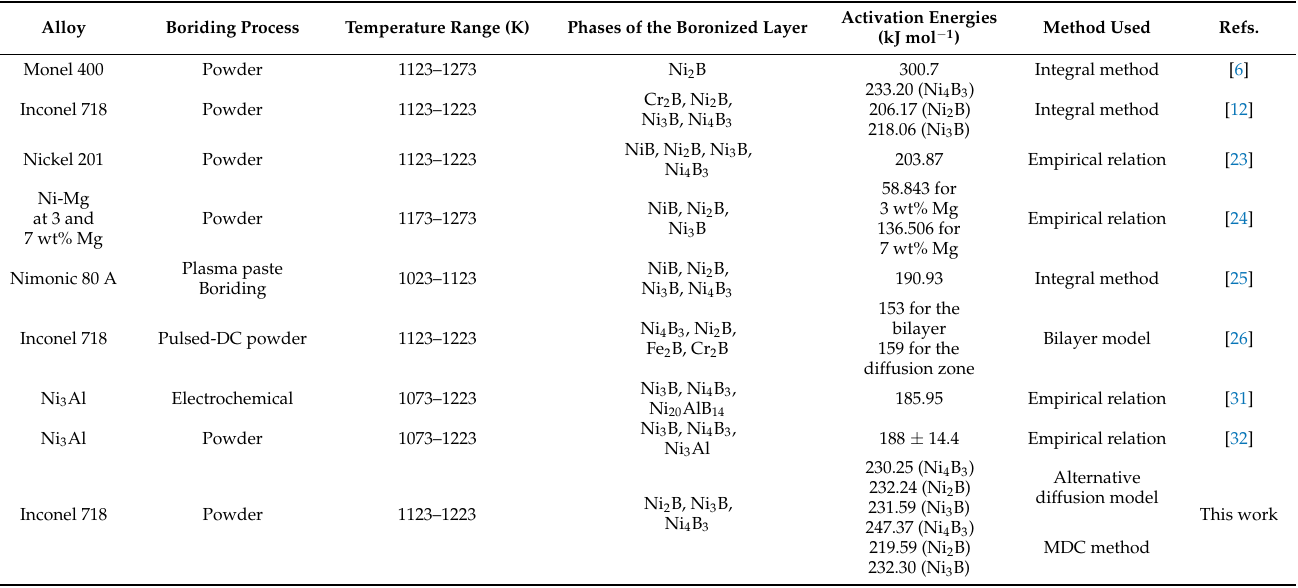
Table 5. Values of boron activation energies in nickel alloys for different boronizing